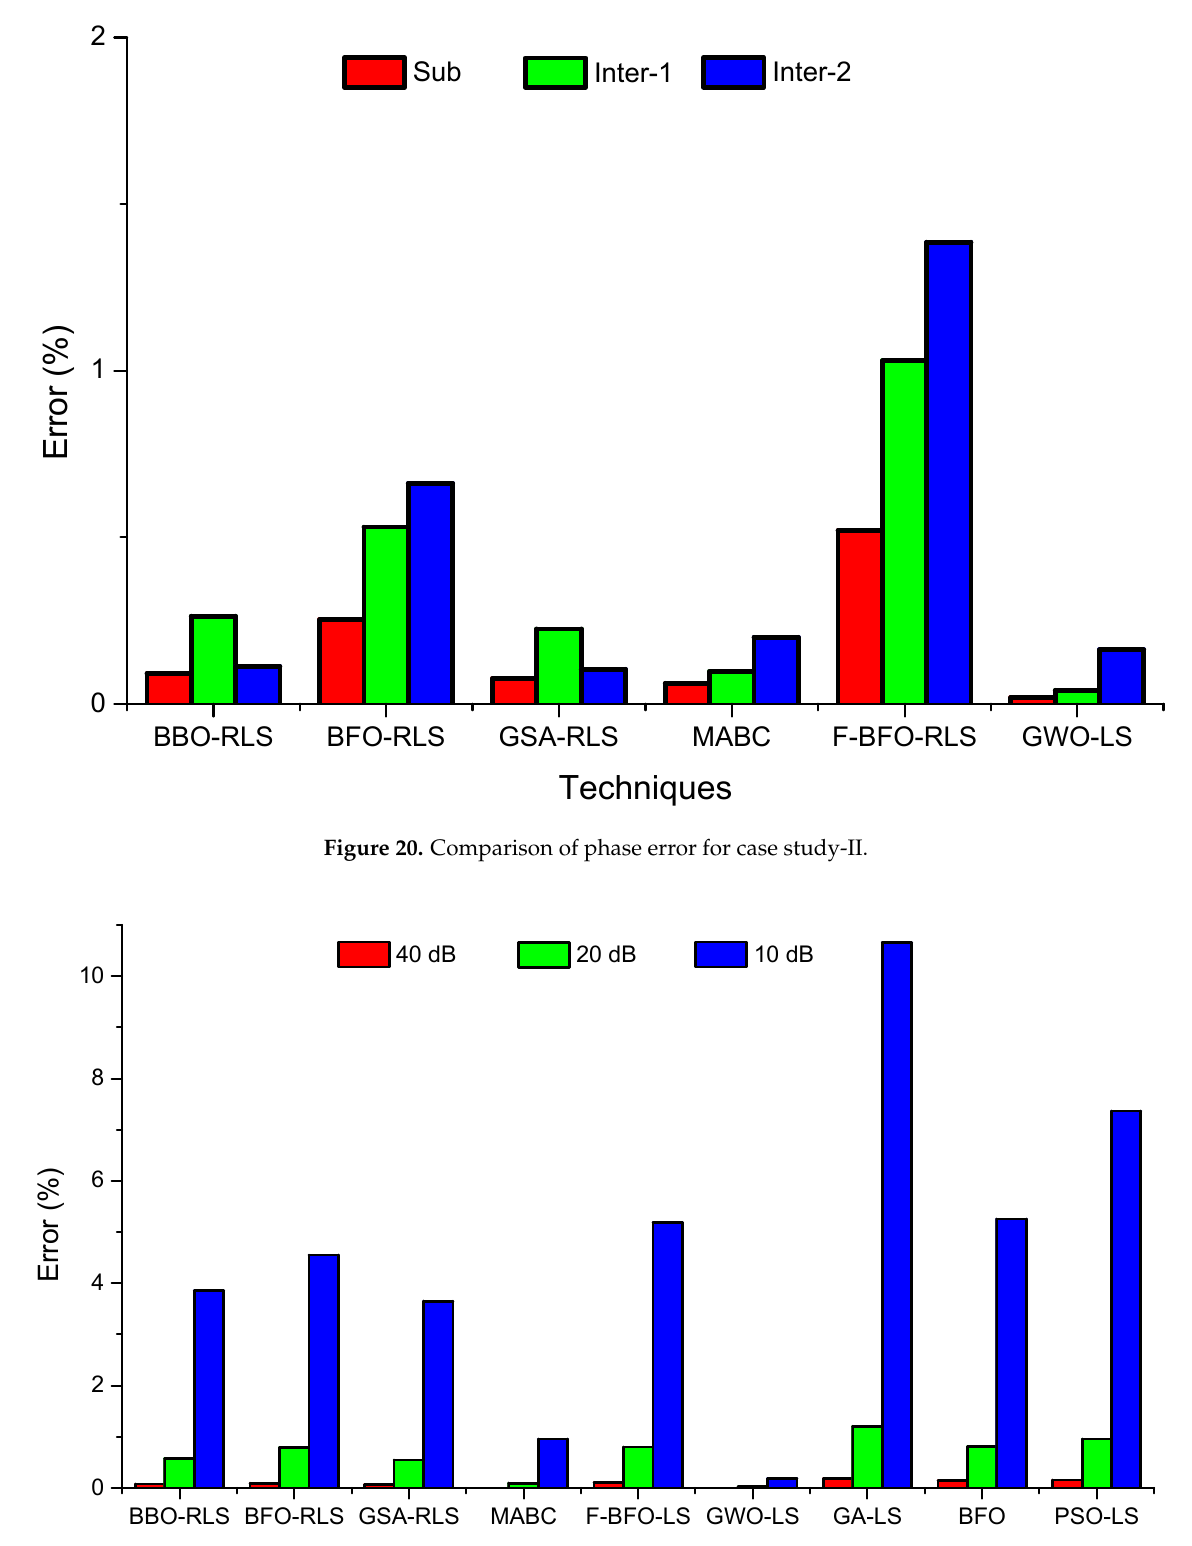
Figure 19. Comparison of amplitudes erros for case study II.